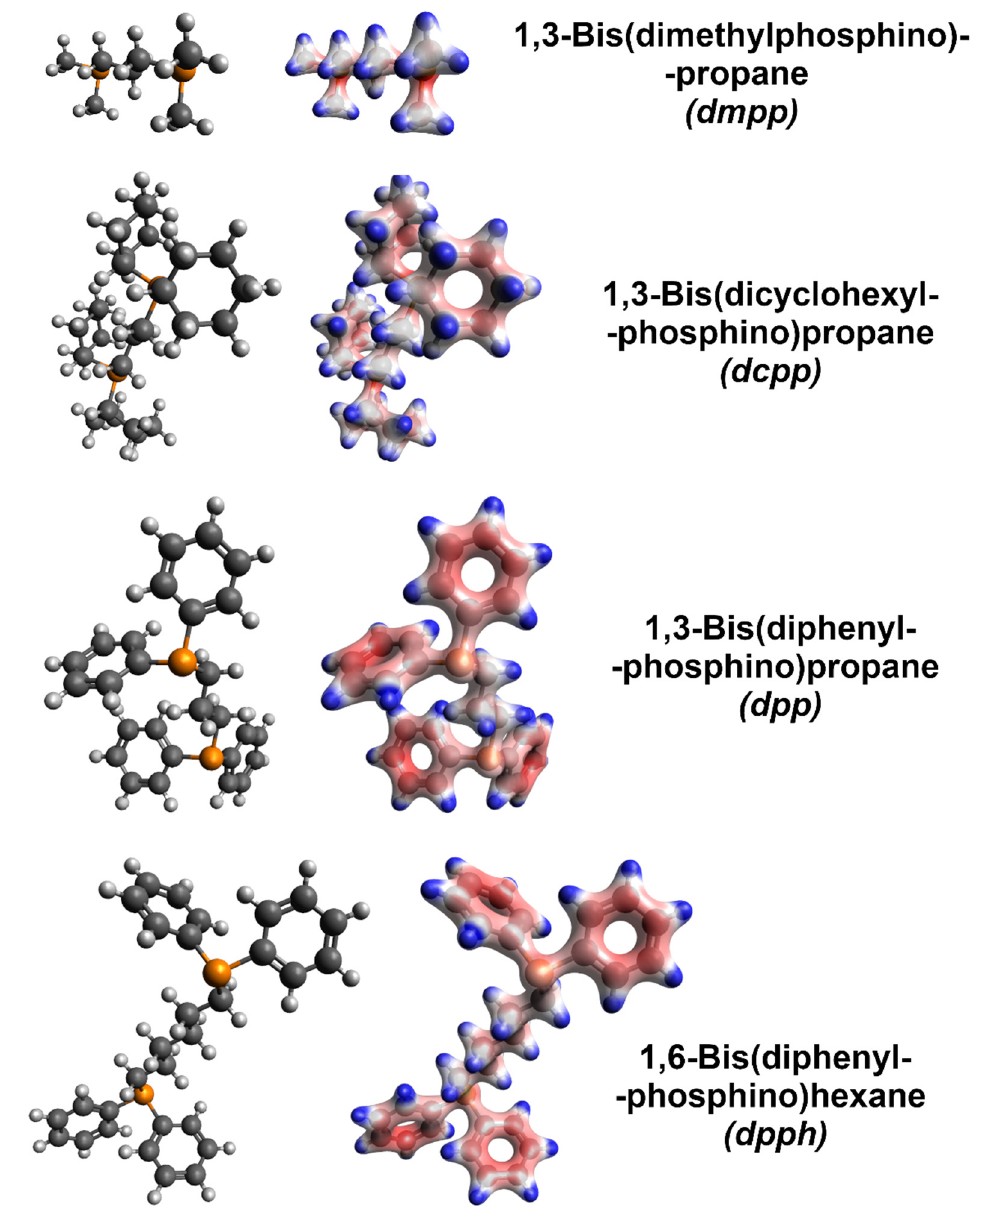
Figure 5. Left column: bare molecular models of the organophosphorus dopants (grey—carbon, white—hydrogen, and orange—phosphorus). Right column: corresponding molecular models with electron densities overlaid obtained by computation (red—negative charge and blue—positive charge).